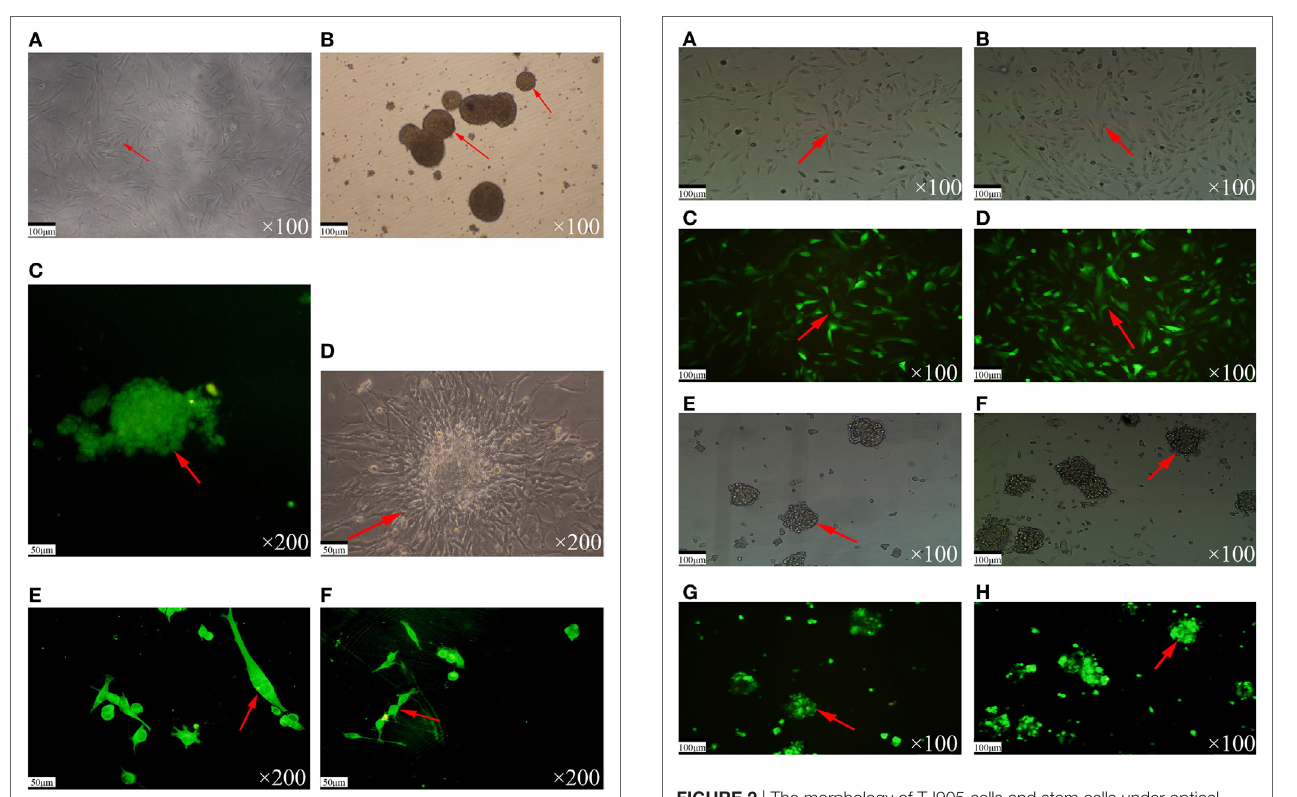
FigUre 1 | Separation and identification of glioma stem cells. (a) The TJ905 cells were cultured in serum-free medium. The cells grew closely with few pseudopodia. (B) The TJ905 stem cells grew together to spheres in suspension after 3–4 days. (c) Immunofluorescence staining showed that the nestin immunostaining for spheres was strongly positive. (D) After culture in medium containing 10% fetal bovine serum, the spheres differentiated, appearing with many pseudopodia and showing many kinds of irregular shapes, such as triangle, round, and star shapes. (e) The GFAP immunostaining for differentiated glioma stem cells was strongly positive and nestin staining was negative. (F) The β -tubulin immunostaining for differentiated glioma stem cells was strongly